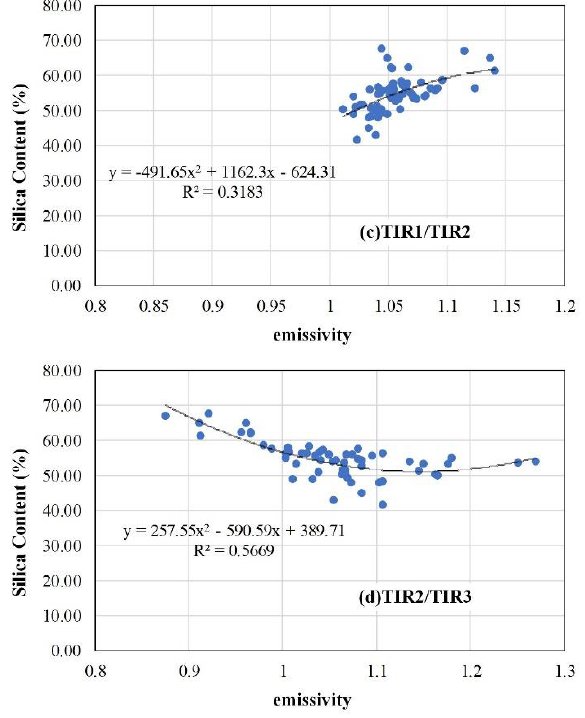
Figure 5 Correlation models established between GF-5’s TIR band emissivity/spectral indices of silicate and silica content.